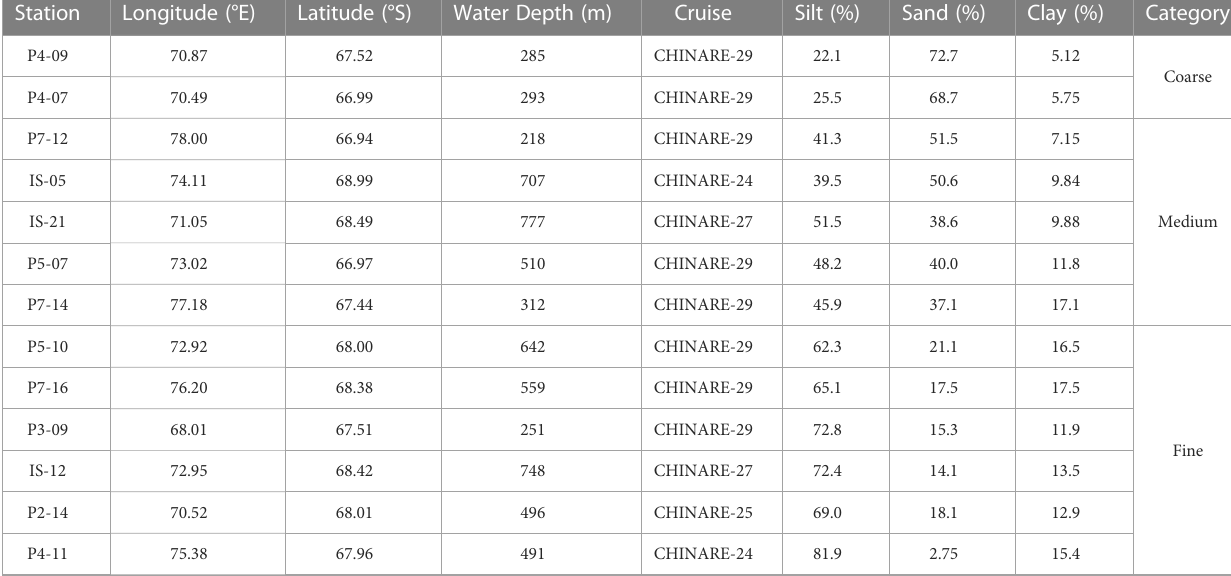
TABLE 1 Sampling information, sand, clay, silt and categories of surface sediment from Prydz Bay and the adjacent Southern Ocean.